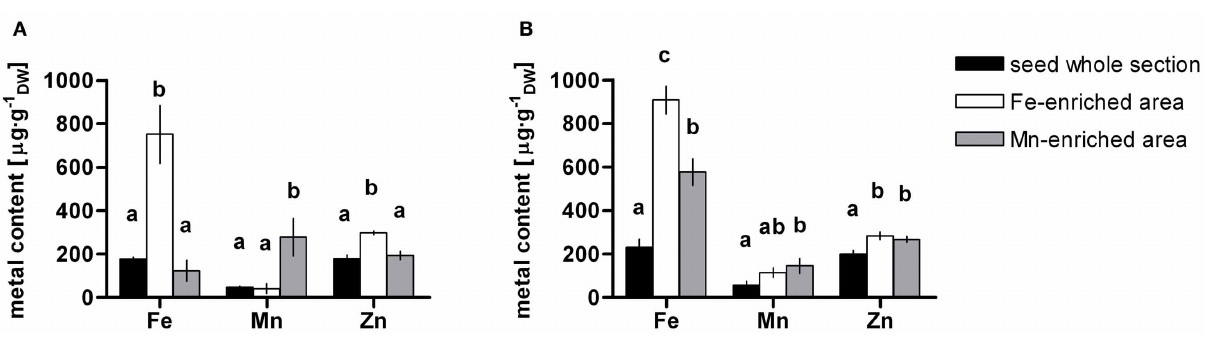
Values are means ± SE ( n = 3–4 scanned sections). Different letters denote statistically significant differences based on Kruskal–Wallis test followed by Tukey post-hoc test comparing values of dry and imbibed seeds for each metal ( P < 0 . 05).